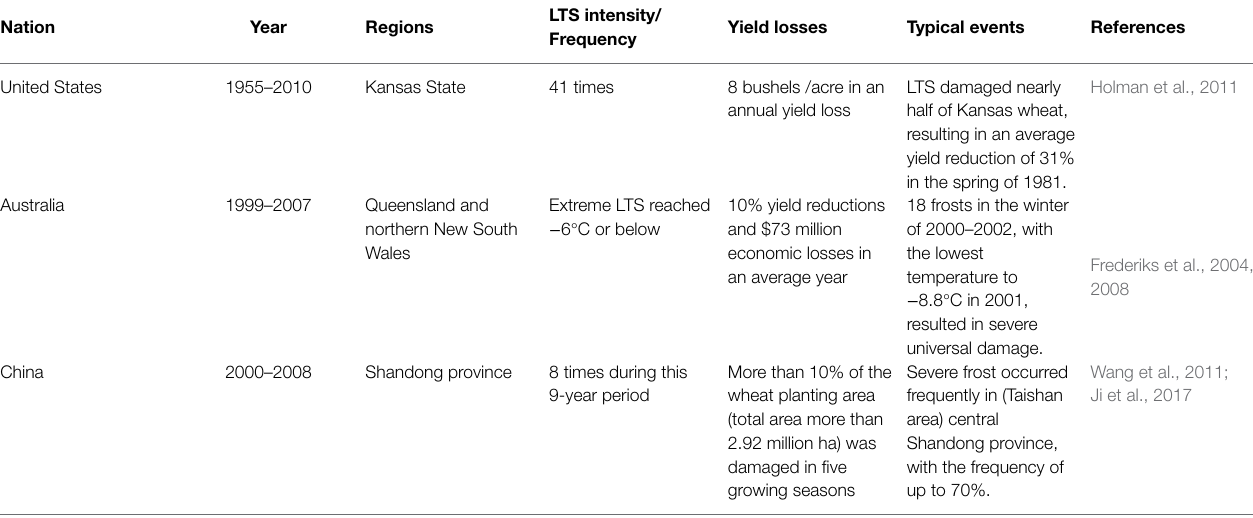
TABLE 1 | Effects of LTS on yield and typical events in major wheat producing